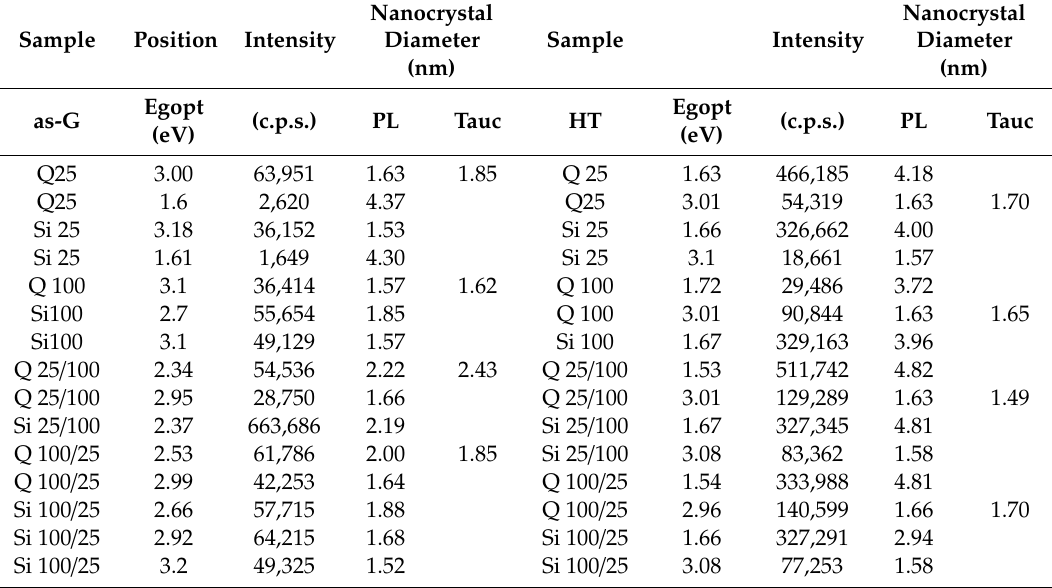
Table 5. Estimated values of the Eg opt and diameters of the Si-ncs calculated by the absorbance of the SRO films.